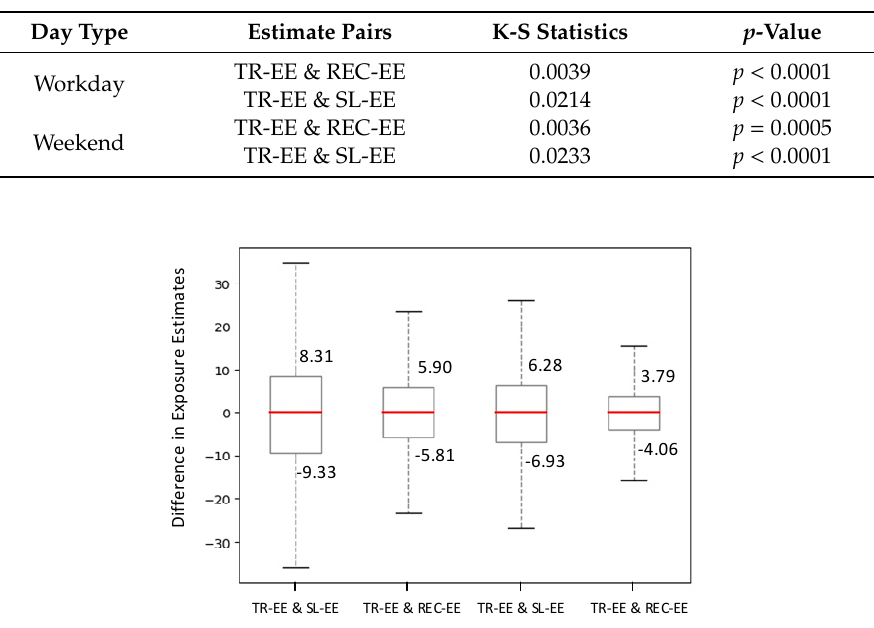
Table 4. K-S test results.